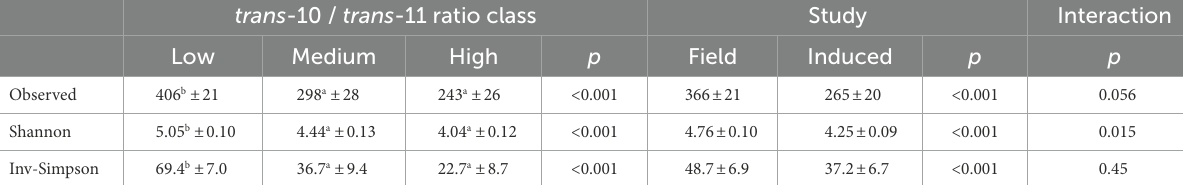
TABLE 1 Alpha-diversity of rumen microbiota across trans -10/ trans -11 ratio classes and